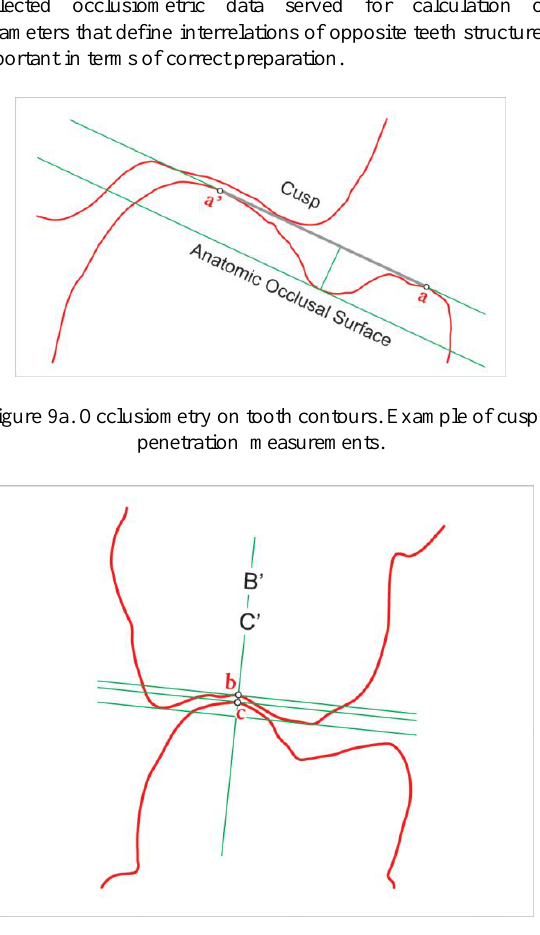
Figure 9b. Occlusiometry on tooth contours. Example of cusp deviation measurements.